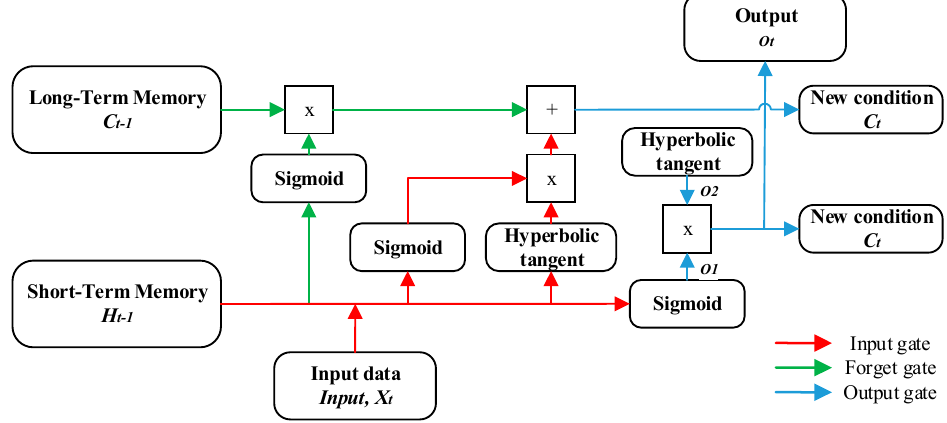
Figure 3. Schematic diagram of signal propagation for the LSTM model of a recurrent neural network.